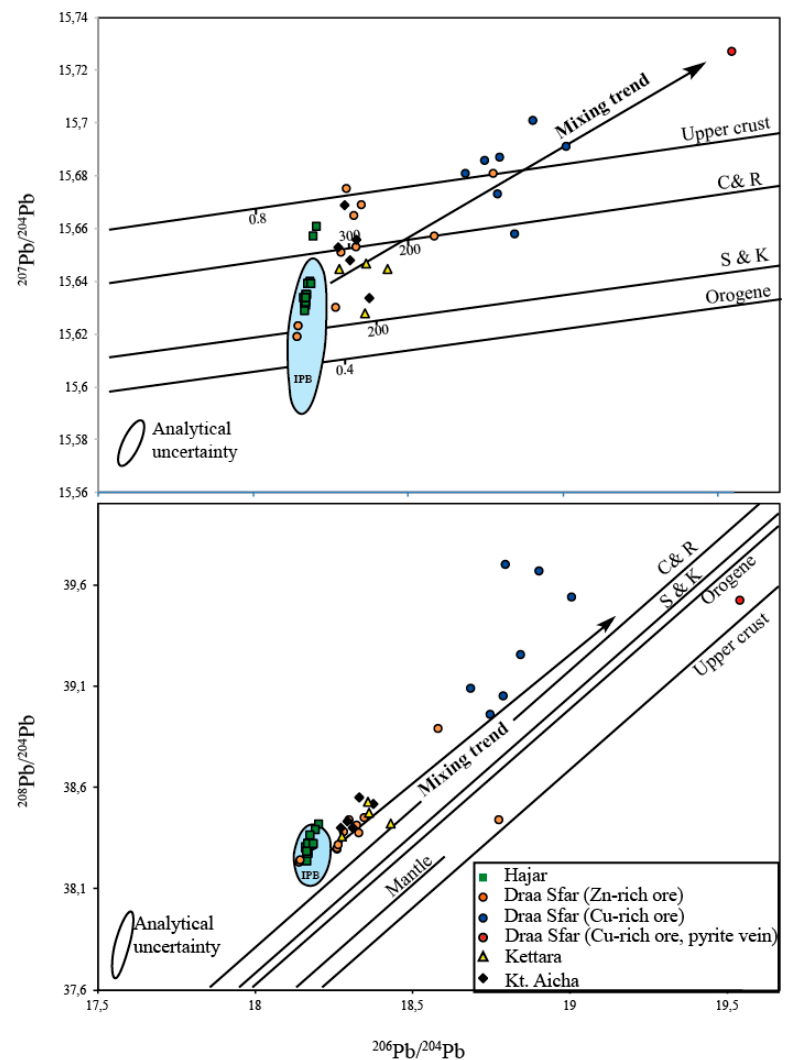
Figure 10. Lead isotopic compositions of the MMSD as compared to the lead isotopic compositions of the IPB VMS deposits (Blue field; [135]). Data from [18,22,133,134]; S and K: average growth curve of Stacey and Kramers [136], C and R: upper crust growth curve of Cumming and Richards [137]. Evolution curves for Upper Crust and Orogene [138] are shown for reference.